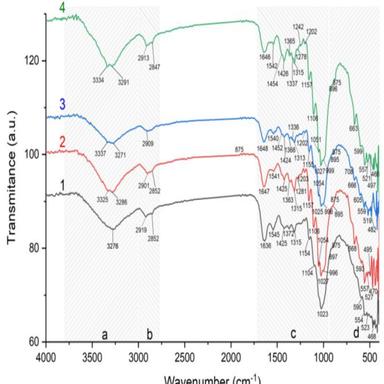
ATR-FTIR spectra recorded for the four analyzed samples